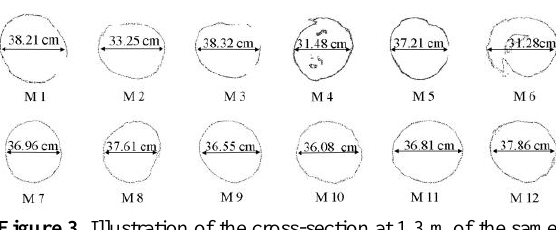
results (13.03%) were achieved by method 5 (Table 3).